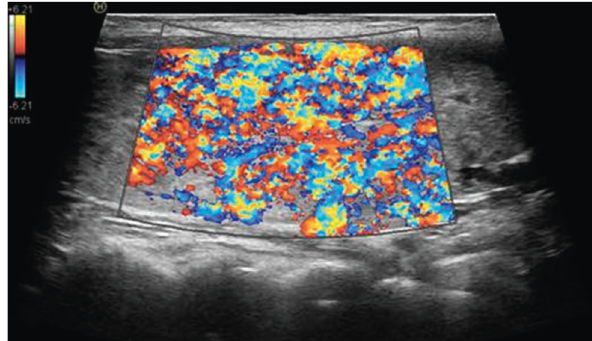
Figure 2: Color Doppler ultrasound grading of hyperthyroidism level